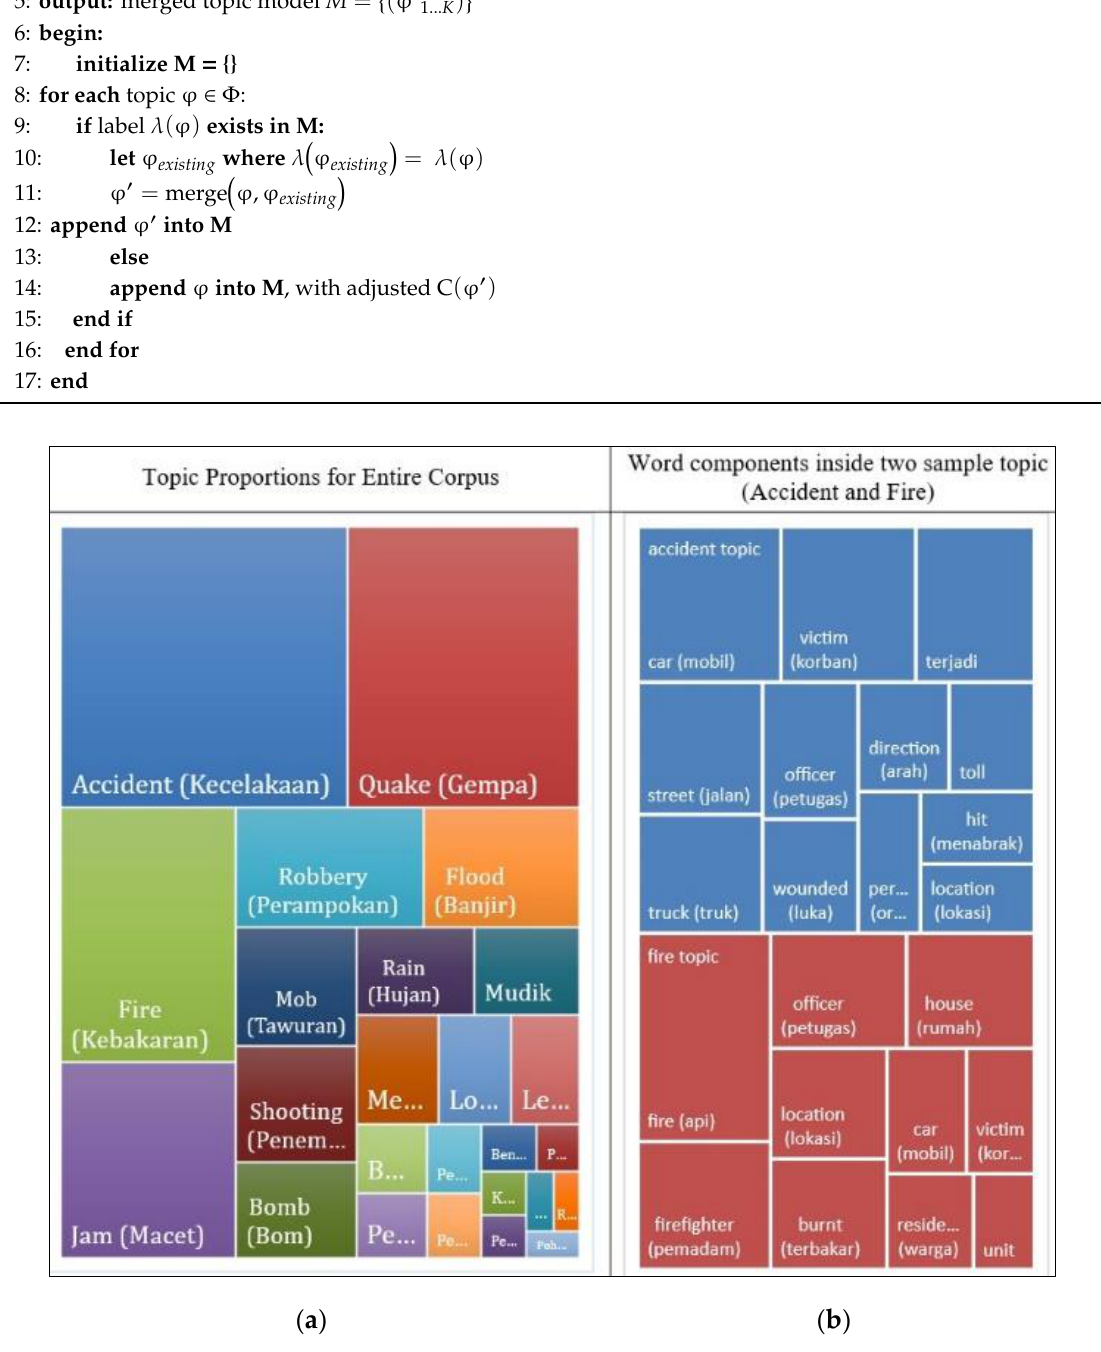
Figure 7. Treemap of Topic Proportions ( a ) and the top-words from Two Sample Topics (accident and fire) ( b ). The area shown on the left figure is determined by the number of topic assignments to that particular label / C( ϕ ). The area shown on the right figure is determined by the probability of each word within that topic / P ϕ k(w 1 ).